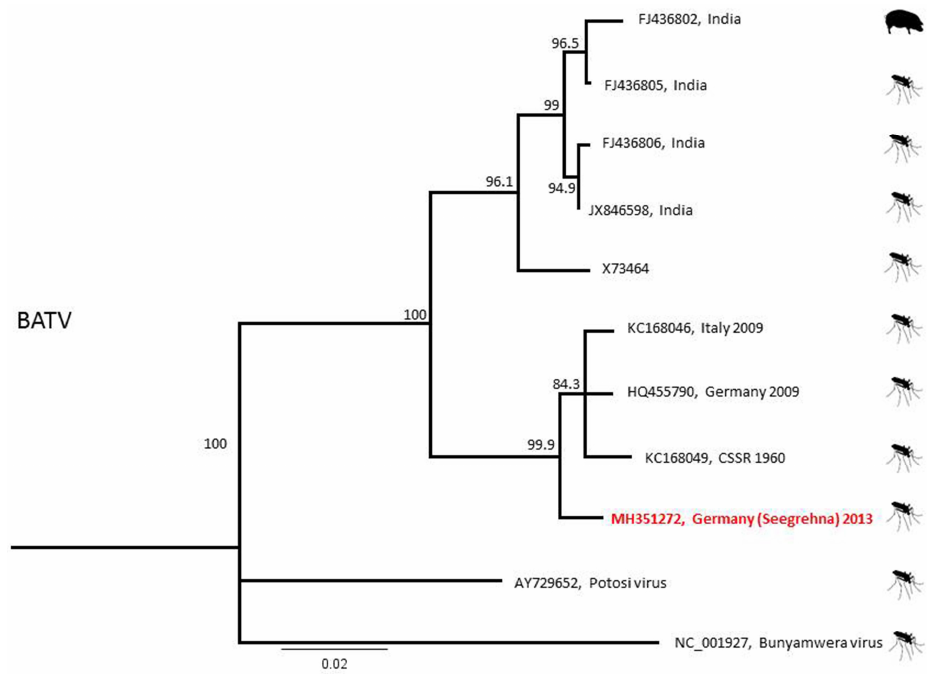
Figure 5. Phylogenetic tree of BATV based on the 541 nucleotide viral S-segment. Red text marks samples of this